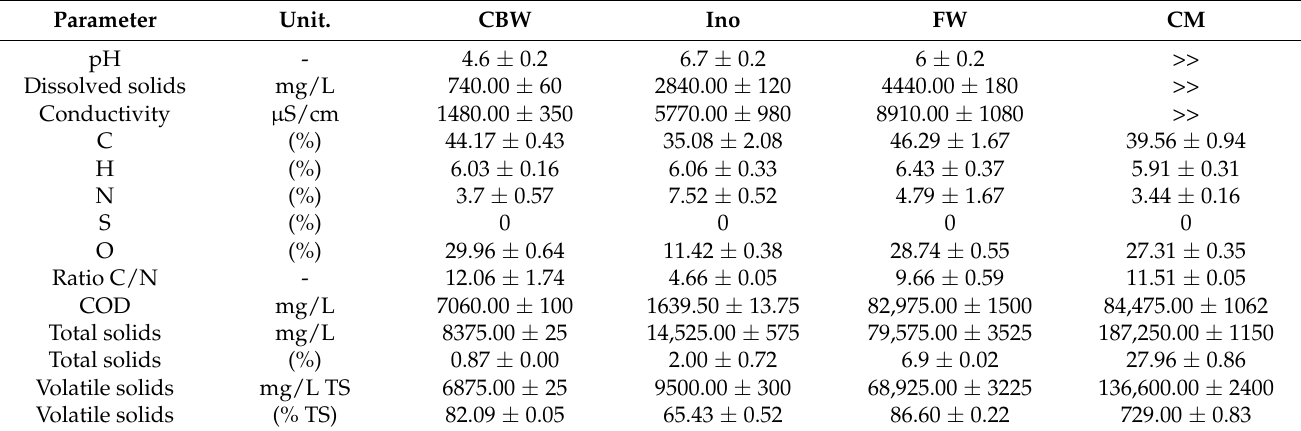
Table 1. Characterization of the substrate, inoculum, and cosubstrates